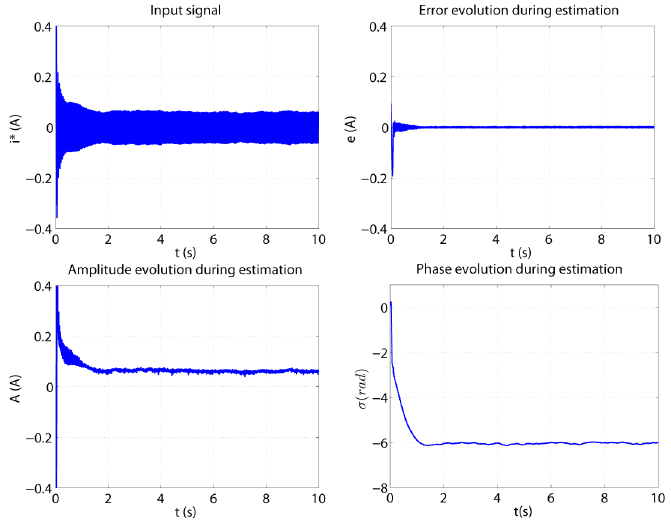
Fig 13. Online parameters estimation graphs for one filtered